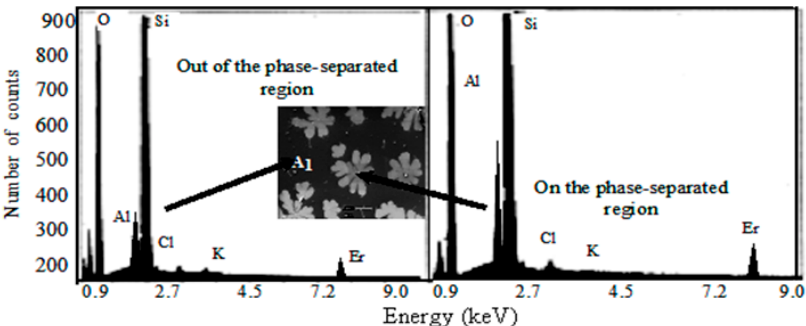
Figure 15. Energy dispersive X-ray (EDX) spectra from inside and outside the phase-separated region of aluminosilicate glass-based Er 2 O 3 -doped preform ( A1 ).